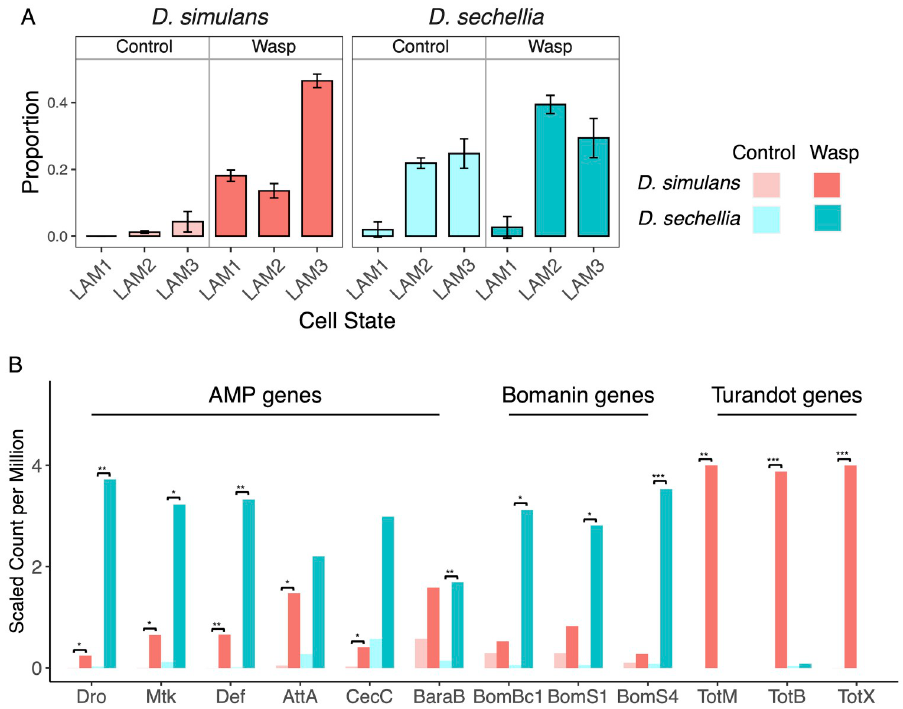
Fig 3. Changes in gene expression after immune challenge. (A) Proportion of lamellocytes in different transcriptional states in D. simulans and D. sechellia larvae under control and immune-challenged conditions, estimated from bulk RNA-seq data with CIBERSORTx. Error bars are 95% confidence intervals. (B) Changes in the expression of immunity genes in the D. simulans and D. sechellia fat body after immune challenge. Bars represent the scaled mean count per million of gene expression in control larvae and 24 hours after injection with mineral oil containing wasp homogenate. Only genes with a greater than two-fold change in expression in at least one species are shown. Significance of the change in expression after infection was defined by false discovery rate (FDR): 0.05 � , 0.01 �� , 0.001 ���